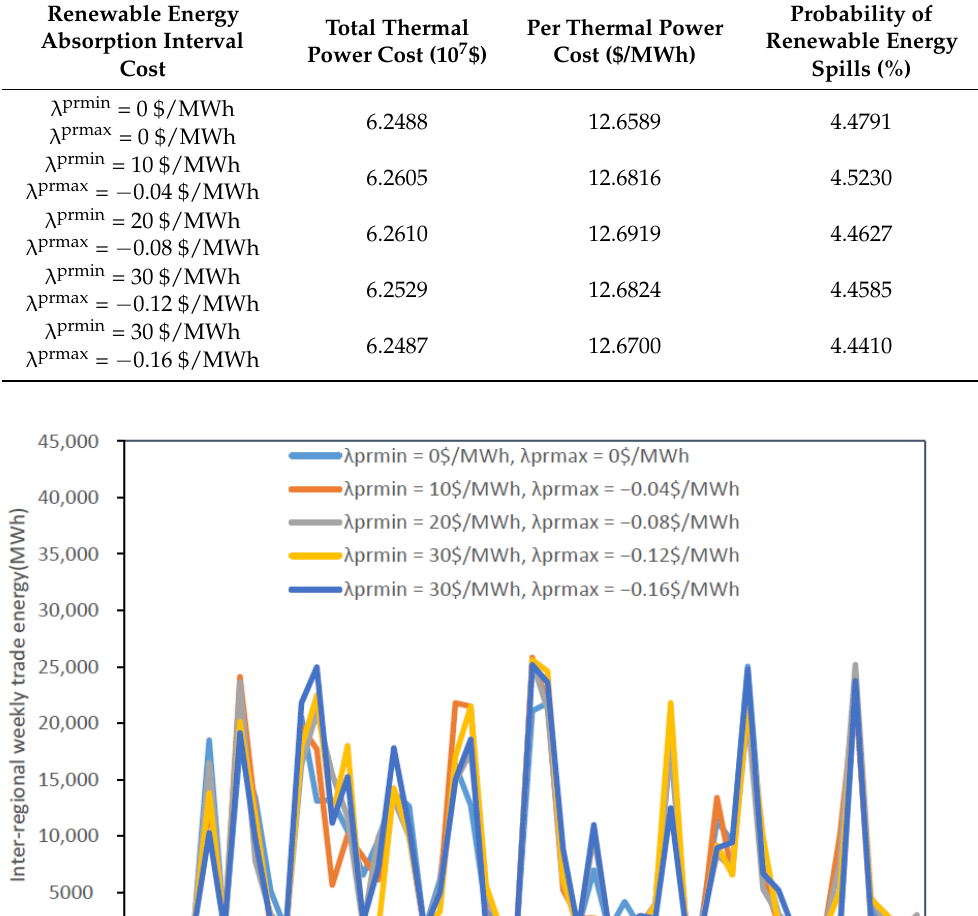
Table 6. Operation indices.